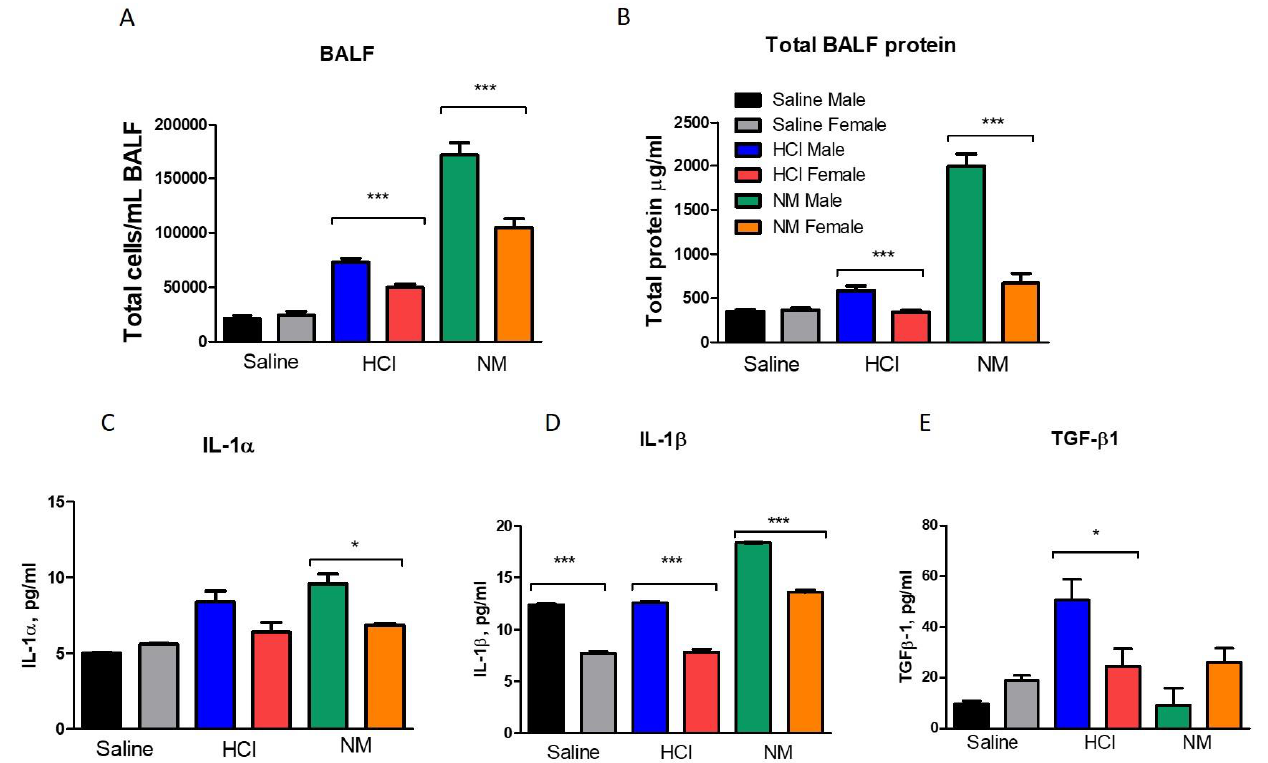
Figure 3. Analysis of Bronchoalveolar lavage fluid (BALF). ( A ) Total cell count; ( B ) total protein concentrations; ( C ) IL-1 α ; ( D ) IL-1 β ; and ( E ) TGF- β 1. Male and female mice were instilled with HCl or NM. Means ± SEM, * p < 0.05; *** p < 0.001 with one-way ANOVA and Tuckey’s, n =6.